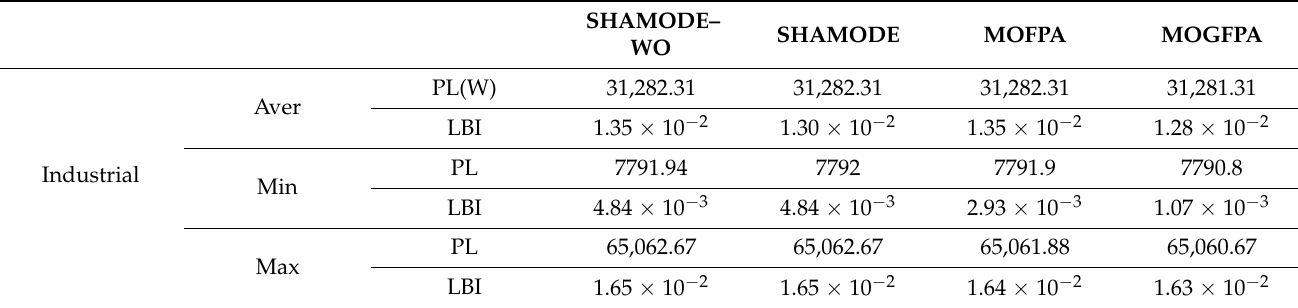
Table 5. PL and LBI comparison under different load conditions (IEEE